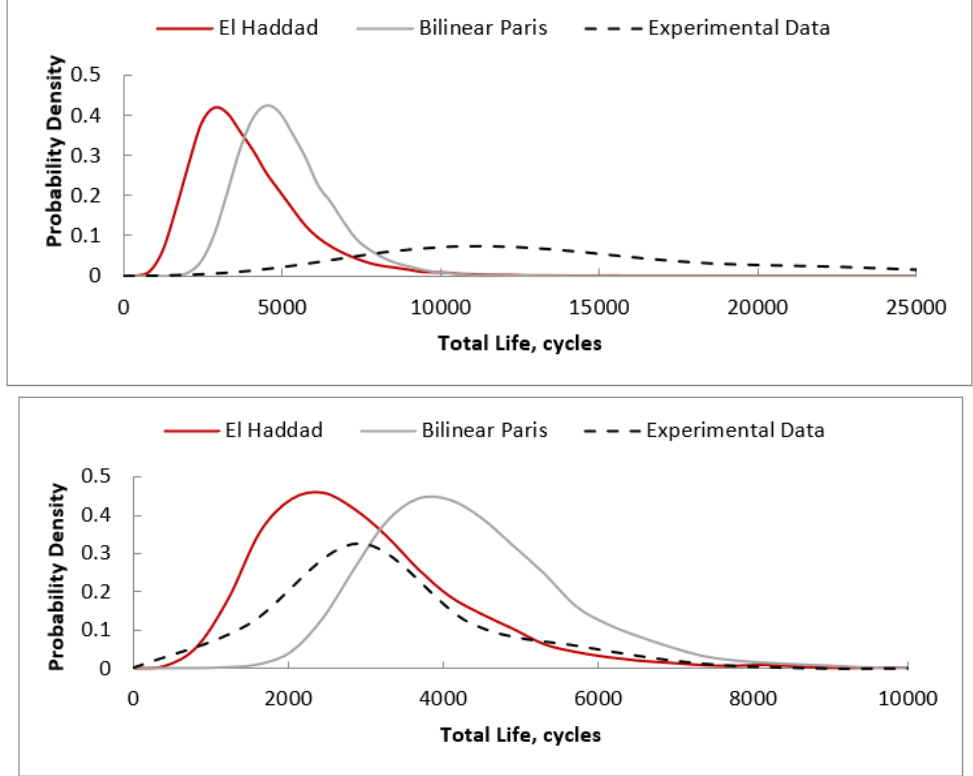
Figure 10. Predicted probability of failure: 750 MPa ( top ) and 800 MPa ( bottom ) compared to experimental data.